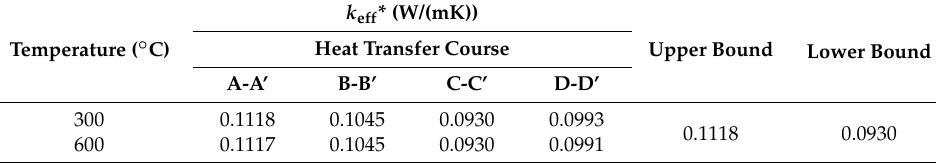
. q (cid:48)(cid:48) = 50 kW/m 2 . irr